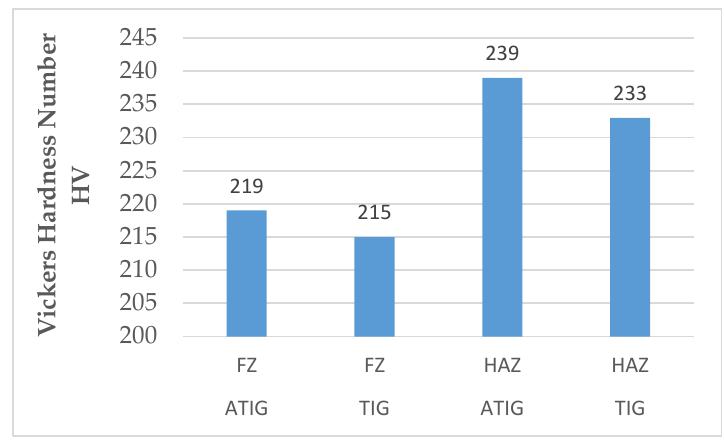
Figure 13. Hardness test results. Table 8. Mesurments of hardness and standards deviation of TIG and ATIG (optimal flux).